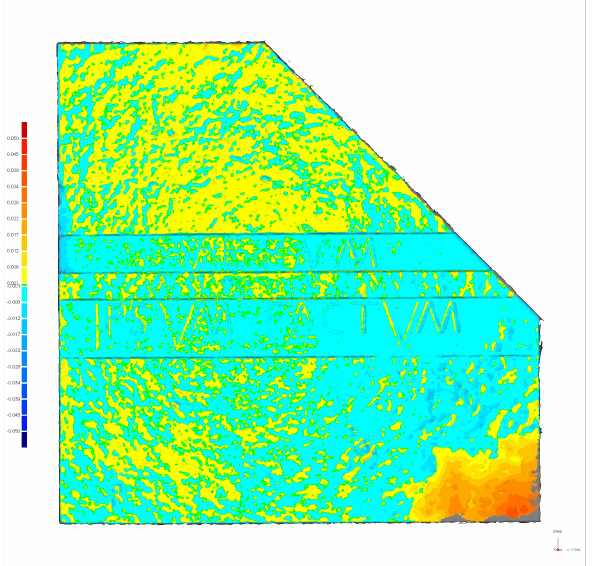
Figure 8. Results of 3d compare of portal